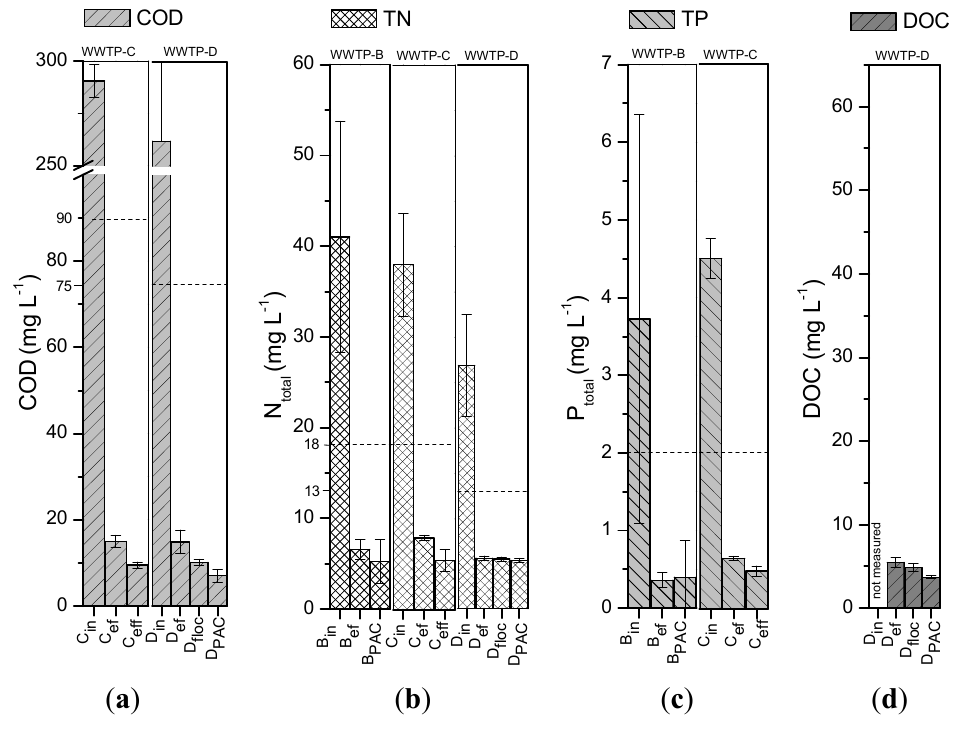
Figure 3. Average concentrations and standard deviations ( a ) Chemical Oxygen Demand (COD); ( b ) total nitrogen (TN); ( c ) total phosphorus (TP); and ( d ) dissolved organic carbon (DOC) measured during sampling at WWTP-B, WWTP-C and WWTP-D. Threshold values of each parameter according the WWTP characteristics are indicated with a line